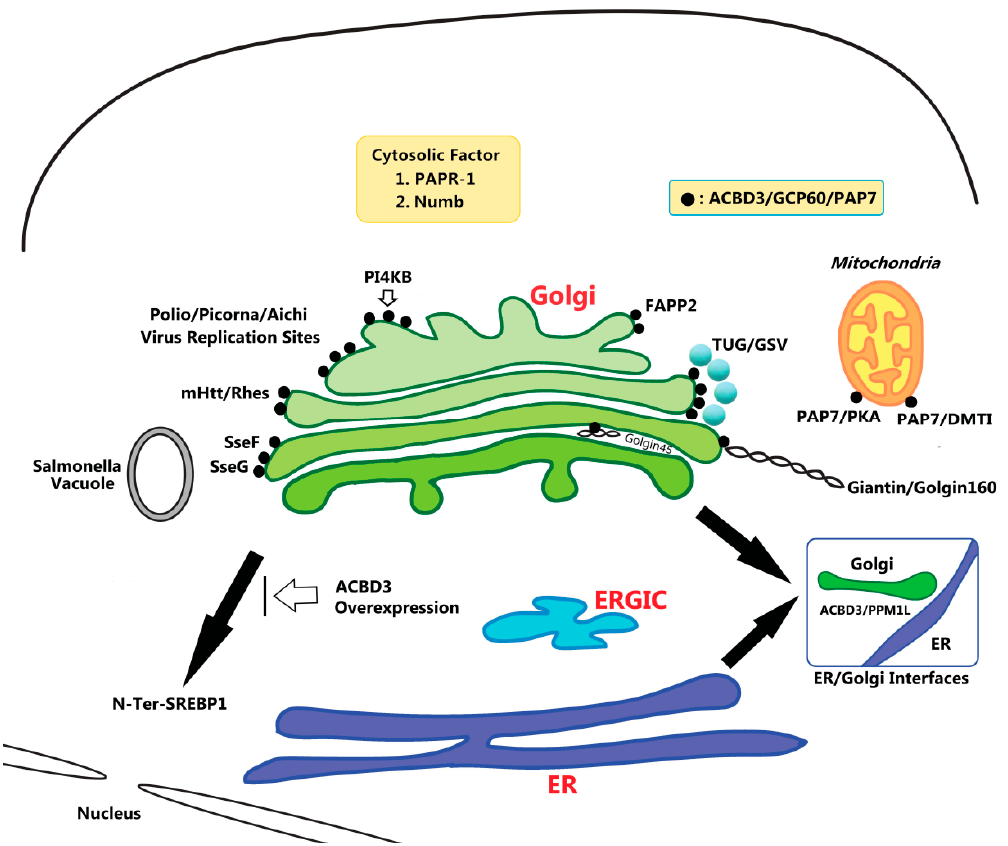
Figure 2. Schematic illustration of diverse roles of ACBD3 and its interaction partners at the Golgi, mitochondria, and cytoplasm in the cells. ACBD3 ′ s physiological roles range from steroidogenesis, neurogenesis, lipid metabolism, cell division, apoptosis, membrane trafficking to proposed roles in various diseases like cancer, diabetes, viral and bacterial replication in host cells, and Huntington’s disease (HD),